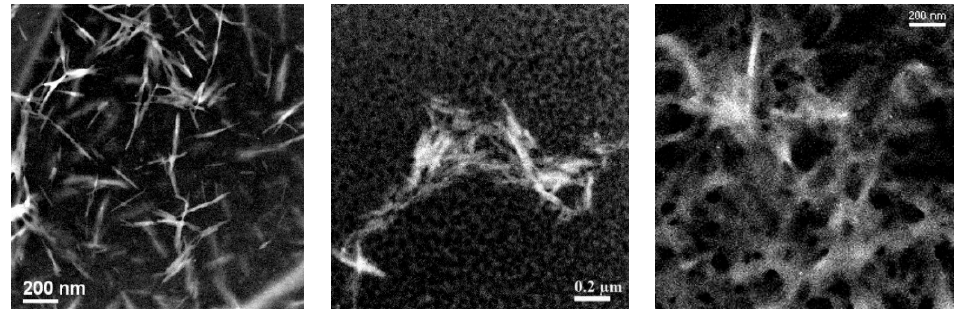
Figure 2. HAADF-STEM images of the samples of CNC-CF, CNC-S, and CNC-NS, from left to right.